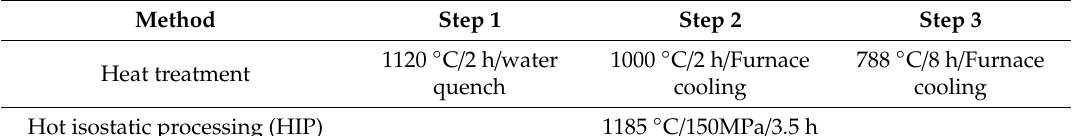
Table 4. Table with details of the heat treatment parameters